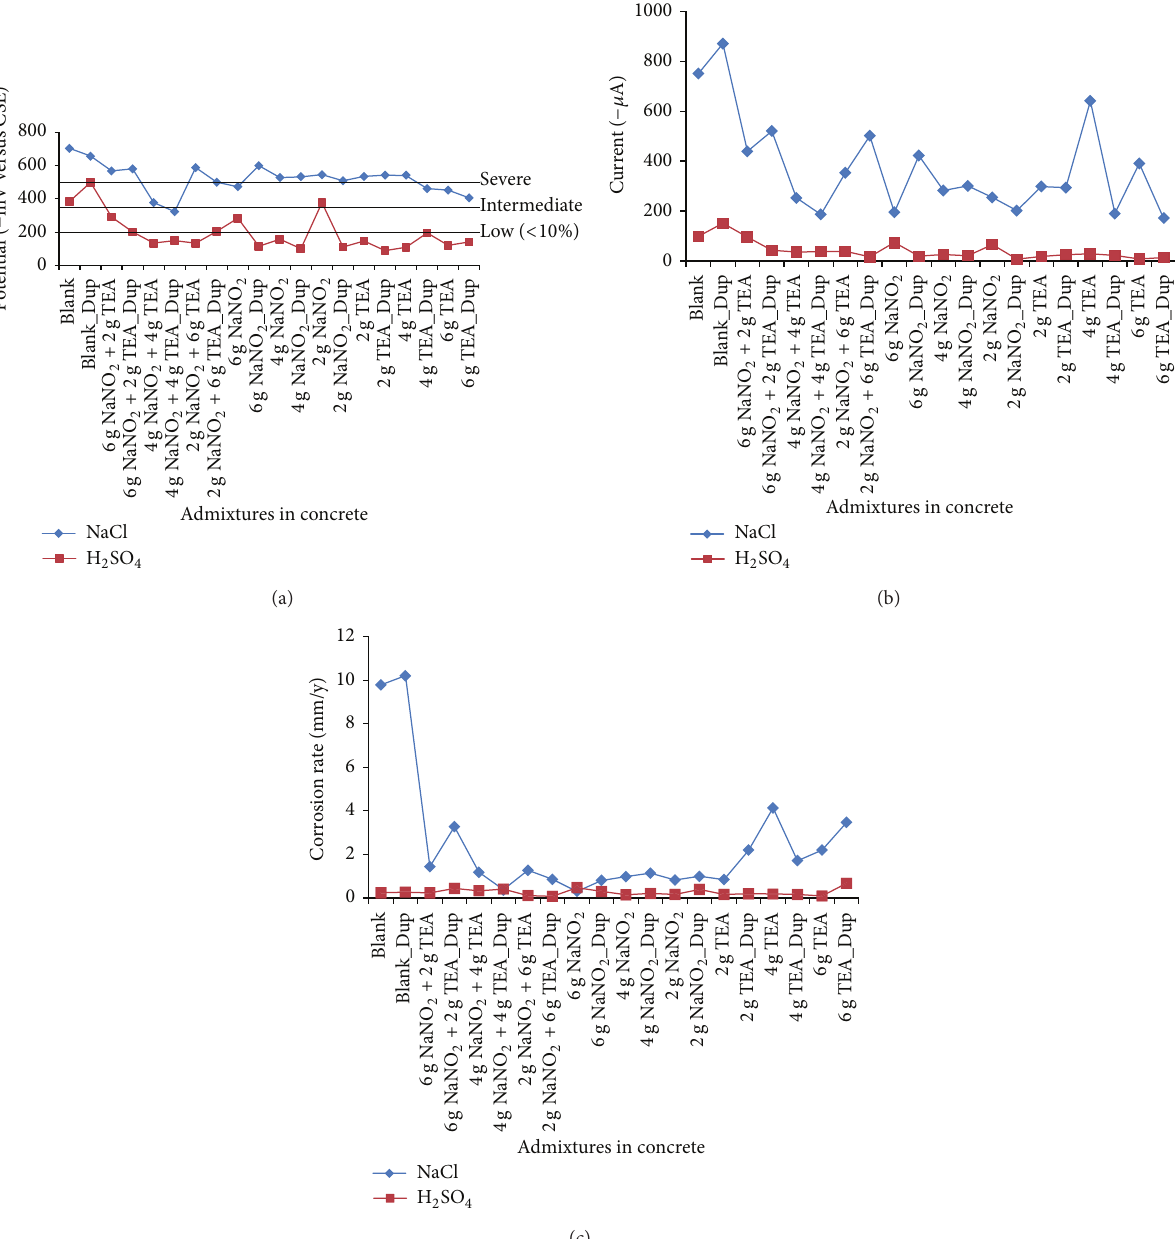
Figure 2: Weibull mean models of the electrochemical test data of steel-reinforced concrete samples immersed in aggressive media for ninety- six days of experimental period: (a) half-cell potential (with corrosion risk levels as per ASTM C876-91 R99 [36]), (b) cell current, and (c) corrosion